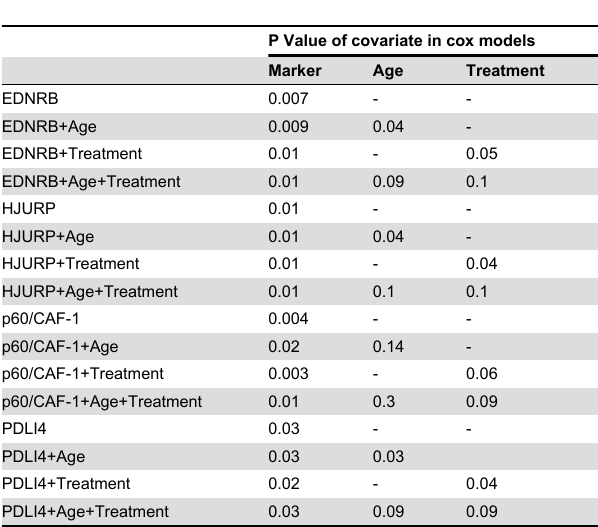
Table 5. Multivariate analysis of EDNRB, HJURP, p60/ CAF-1 and PDLI4.